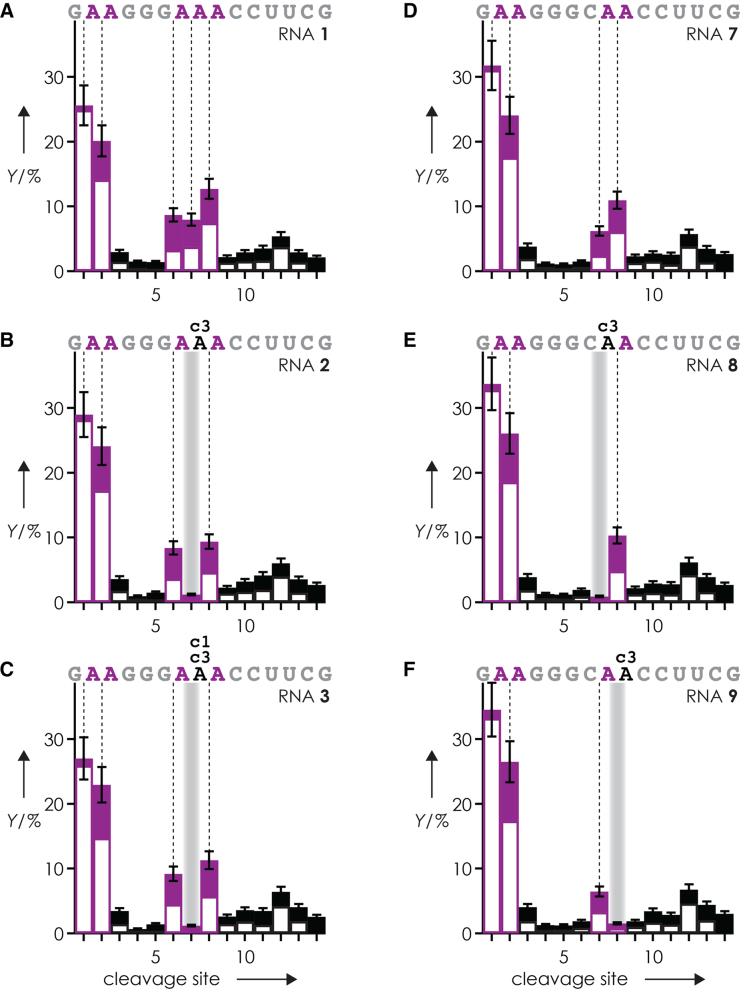
Yield Y of c (filled bars) and y (open bars) fragments (including those that showed H2O and/or nucleobase losses, normalized to the yield of all fragments from phosphodiester backbone bond cleavage) from CAD (42 eV laboratory frame collision energy) of (M+4H)4+ ions of (A) RNA 1, (B) RNA 2, (C) RNA 3, (D) RNA 7, (E) RNA 8, and (F) RNA 9 versus cleavage site, those of fragments from phosphodiester backbone bond cleavage on the 5′-side of A and c3A are highlighted in purple.